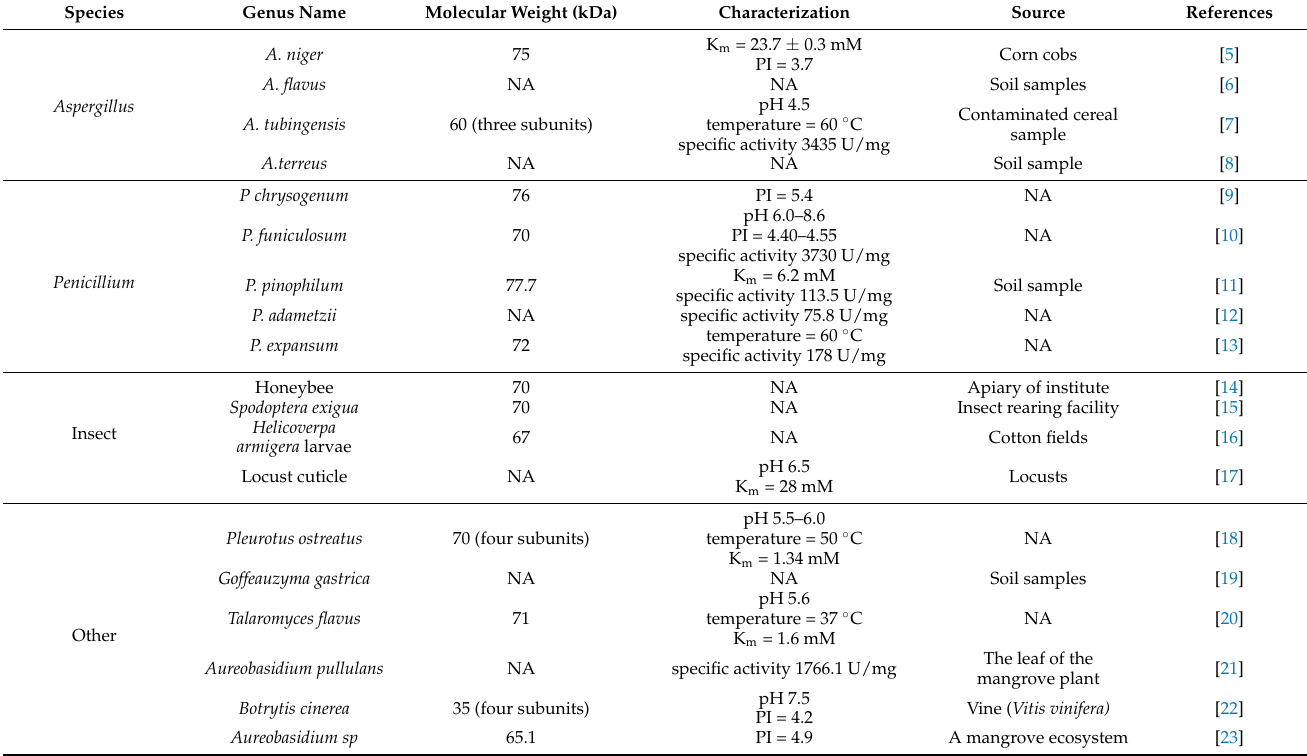
Figure 1. The development process of glucose oxidase. Table 1. The reported strains for glucose oxidase production, and its molecular weight and charac- terization.